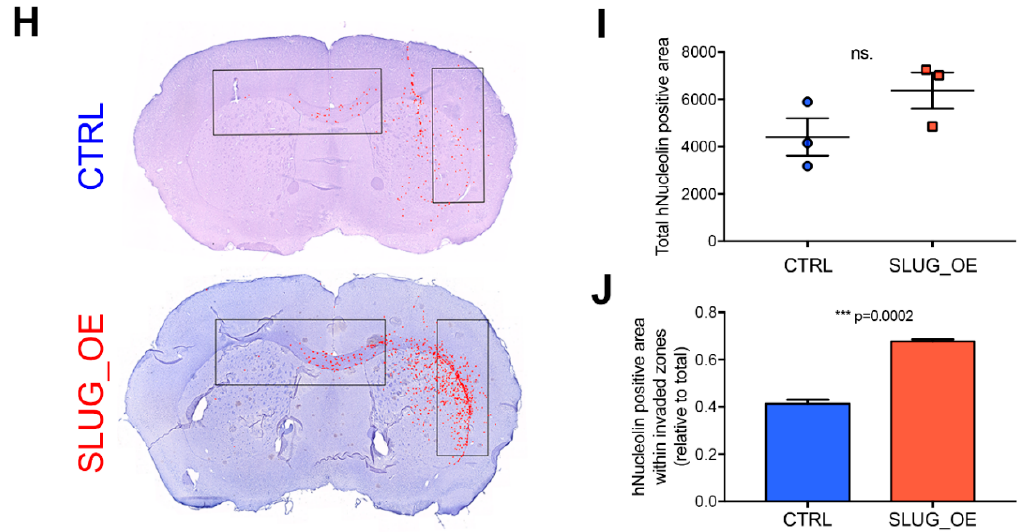
Figure 4. SLUG promotes migration and invasion both in vitro and in vivo (see also Figure S6). Bar graphs representing ( A ) SLUG and ( B ) E-cadherin expression in BT69 control (CTRL) and overexpressing SLUG (SLUG_OE) as measured by RT-PCR (* p < 0.05; ** p < 0.01). ( C ) Representative images of cells on the upper side of the membrane (highlighted in yellow) and cells that have migrated to the bottom side (highlighted in red) and ( D ) quantified migration of CTRL and SLUG_OE cells. ( E ) Graph of STAT3 inhibition (STATTIC) impact on migration of BT69 CTRL and SLUG_OE. ( F ) Representative overlaid images of spheres embedded in collagen at T0 (highlighted in yellow) and pictures of invaded cells at end point (highlighted in red). ( G ) Graphical representation of the quantified invasion of BT69 CTRL and SLUG_OE cells in vitro (area of invaded cells (highlighted in red) was normalized to the area of the imbedded spheres at T0 (highlighted in yellow). ( H ) Representative pictures of the invasive behavior of BT69 CTRL and SLUG_OE cells in a corpus callosum implantation assay. hNucl positive cells were overlaid with large red dots on the high resolution images to illustrate the tumor cell distribution throughout the brain at endpoint. ( I ) Total hNucl positive area throughout the brain sections. ( J ) Graphical representation of the hNucl positive area in invaded zones (represented as rectangles) normalized to total hNucl positive area. Error bars represent SEM ( A – J ).